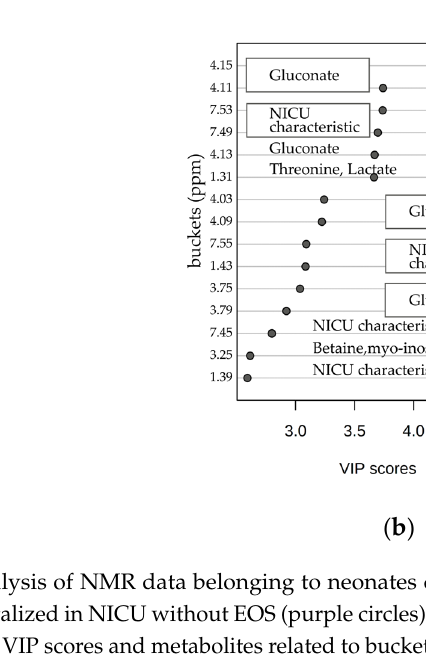
Figure 2. Spectral regions of unassigned chemical shifts mostly present on 1 H NMR spectra of NICU samples (blue spectrum) and healthy non-NICU preterms (black spectrum).